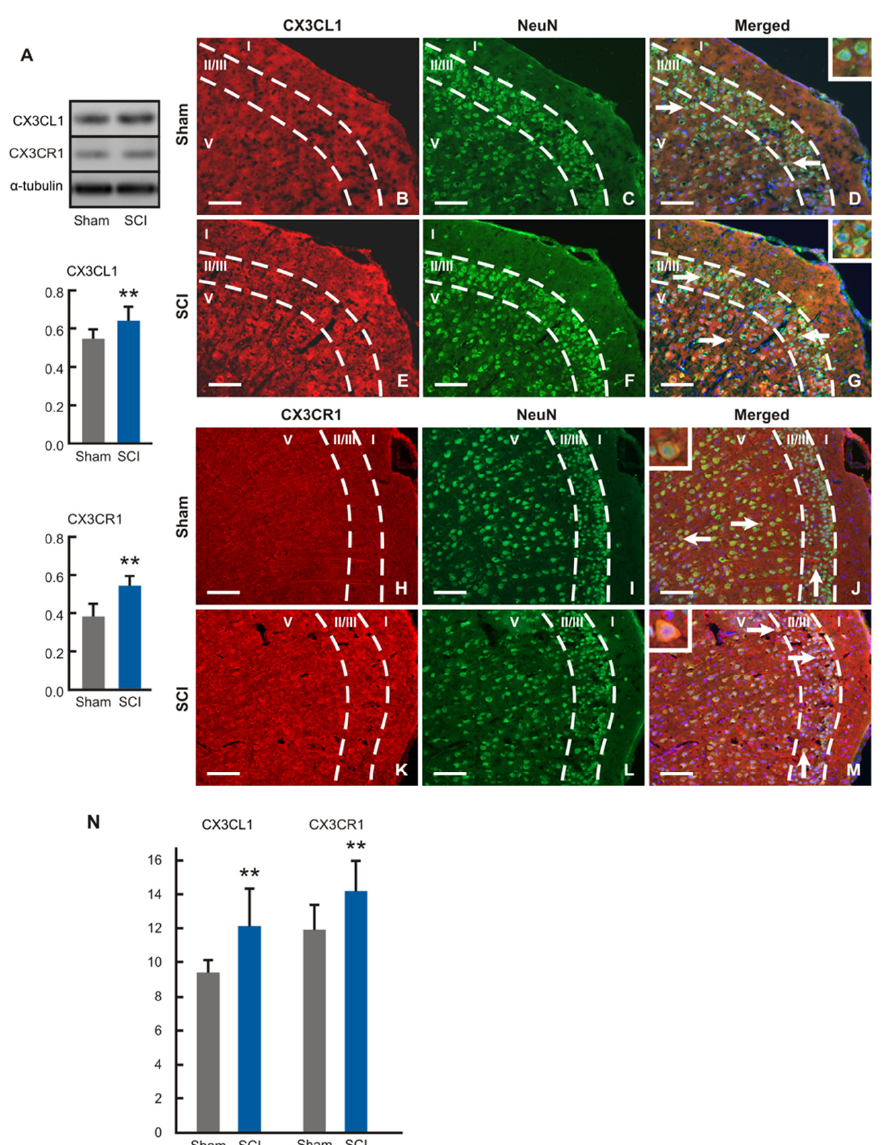
Figure 8. Western blot and immunohistochemical analyses of CX3CL1 and CX3CR1 in ACC. ( A ) Western blot analysis demonstrated significantly increased levels of both CX3CL1 and CX3CR1 proteins in the ACC samples removed from SCI- than sham-operated mice (n = 6 for each group; ** p < 0.01 vs. Sham). ( B – M ) Representative pictures illustrating double immunostaining for detection of CX3CL1 ( B – G ) or CX3CR1 ( H – M ) and NeuN showing neuronal localization of this chemokine and its receptor (arrows and insets) in laminae-II/III and lamina-V of ACC. CX3CL1 or CX3CR1 antibody binding was visualized by TRITC-conjugated and binding of NeuN antibody by FITC-conjugated secondary antibody. In addition, merged pictures contain blue decorated nuclei stained by Hoechst 33,342. Scale bars = 100 µ m. ( N ) Image analyses of immunofluorescence intensities confirmed increased levels of CX3CL1 and CX3CR1 proteins in the ACC neurons of SCI- compared with sham-operated mice (n = 6 for each group; ** p < 0.01 vs. Sham). Full-length blots are presented in Supplementary Figure